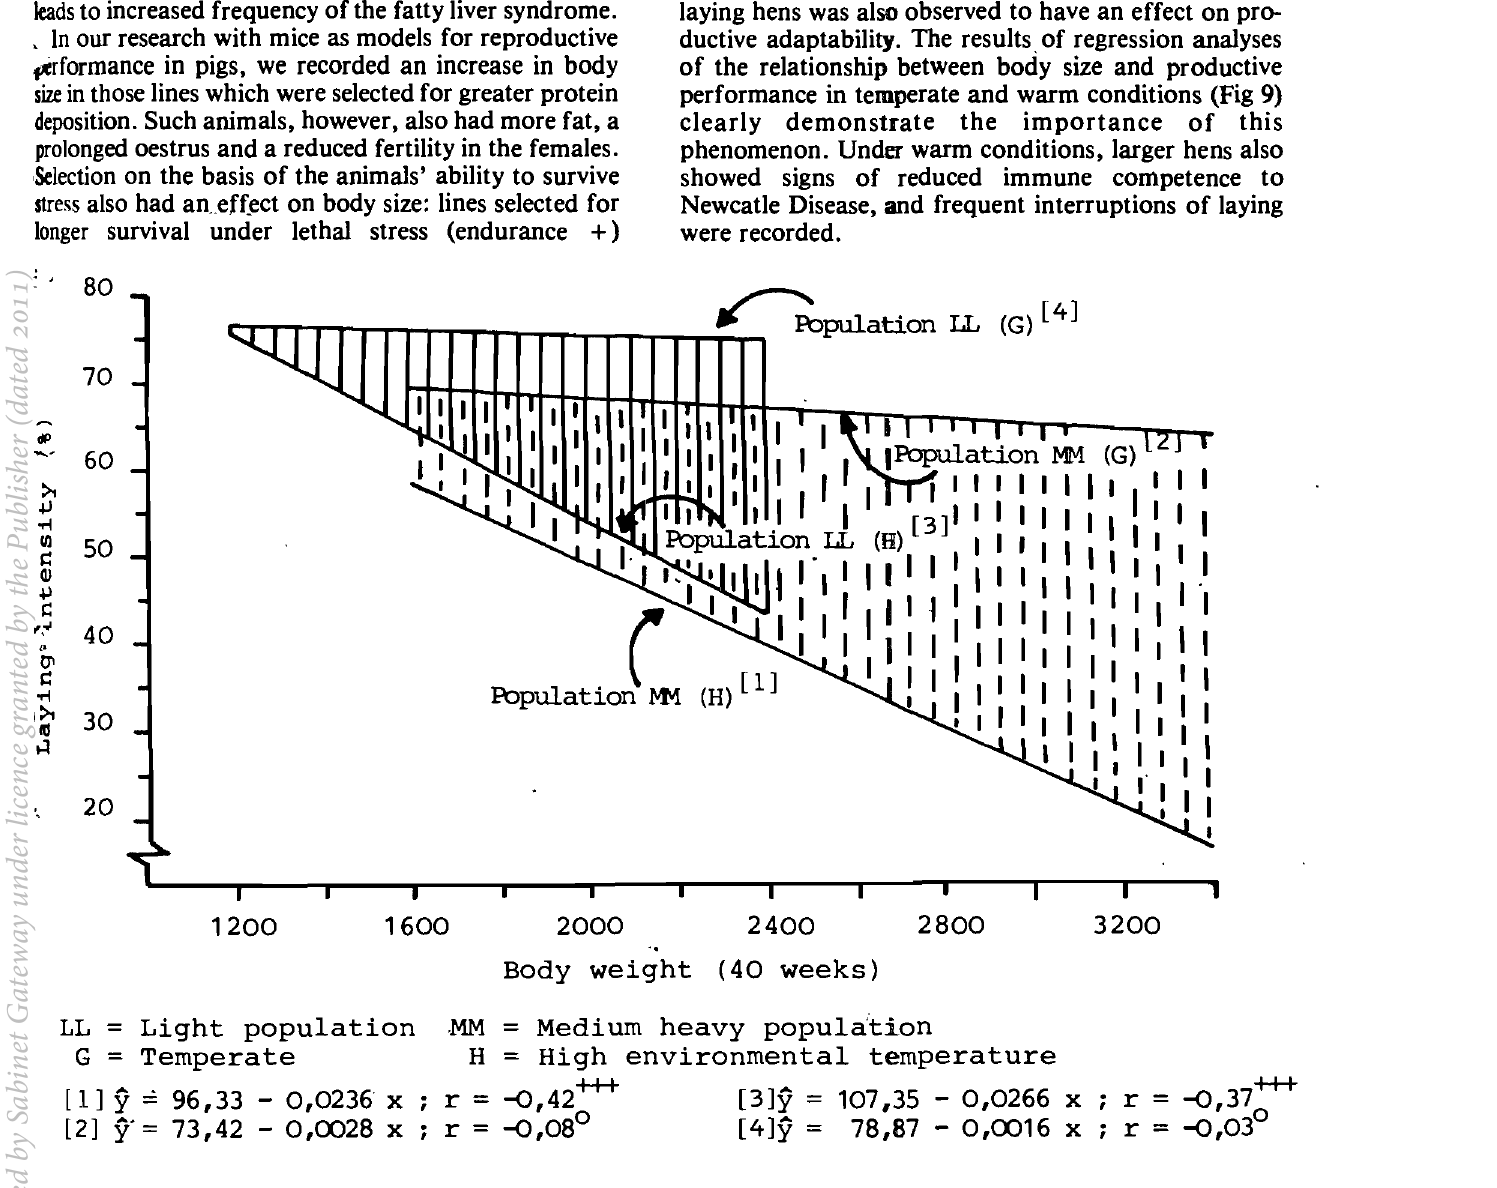
Fig. 8: 50-day body mass in dependence on orientation of selection (adapted from Horst et aI., 1975).